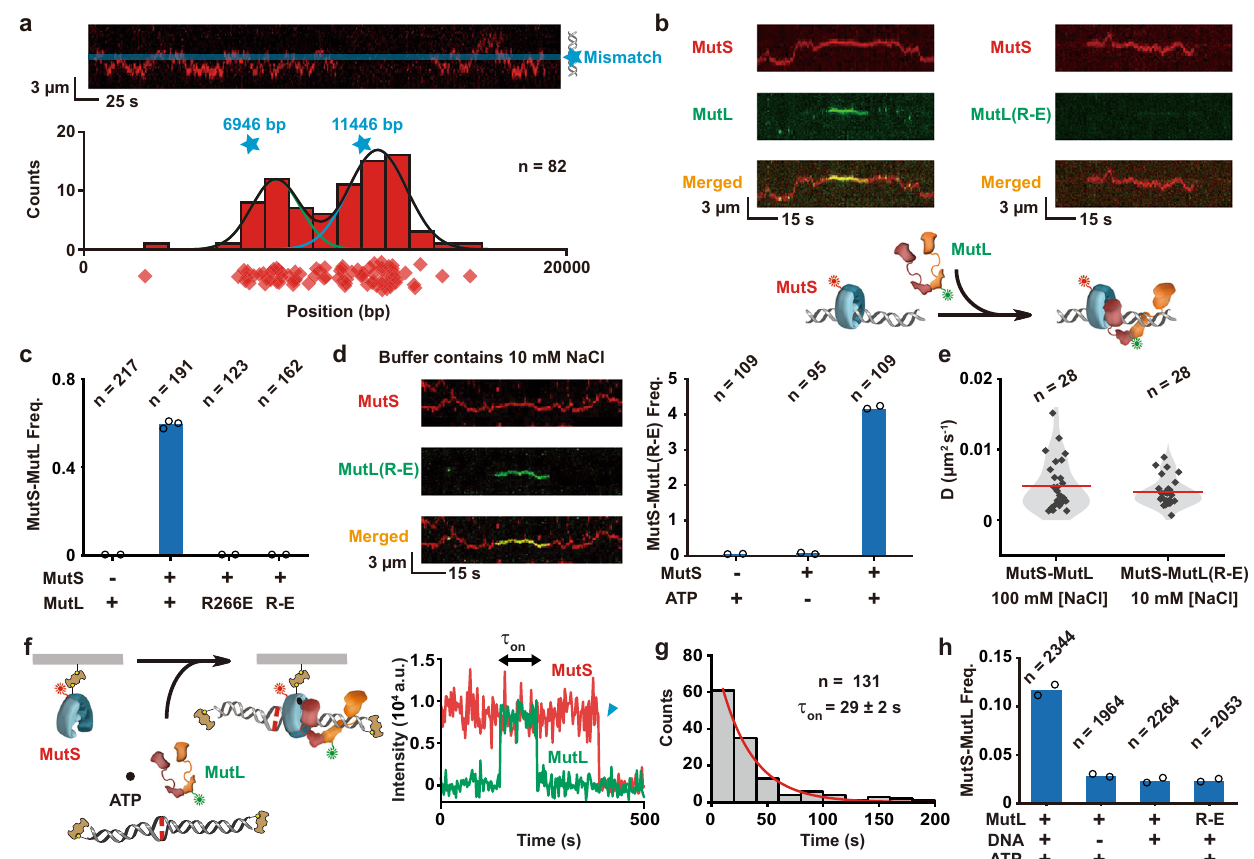
Fig. 2 | MutS sliding clamp enhances loading of MutL onto DNA. a Top: Representative kymograph showing twoindividualMutS sliding clamp events on a single mismatched DNA. Blue star and line indicate the position of the mismatch. Bottom: The distribution of individual initial binding location for MutS bound to the DNA. Diamonds represent individual starting point and the blue stars indicate the two possible positions of the mismatch on randomly attached substrate DNAs ( n =number of events examined). Gaussian fi ts to the distribution of individual initial binding location are shown as lines. b Representative kymographs (top) and illustration (bottom) showing that a Cy5-MutS sliding clamp can recruit wild-type Cy3-MutL (left) onto the mismatched DNA, while there is no recruitment of MutS- MutL(R-E)(right)atphysiologicalionicconditions(buffercontaining100mMNaCl, ~120mM). c The frequency of MutS-MutL complexes under physiological ionic conditions (~120mM, n =total number of DNA molecules examined). d Representative kymographs (left) and frequency of MutS-MutL(R-E) complexes